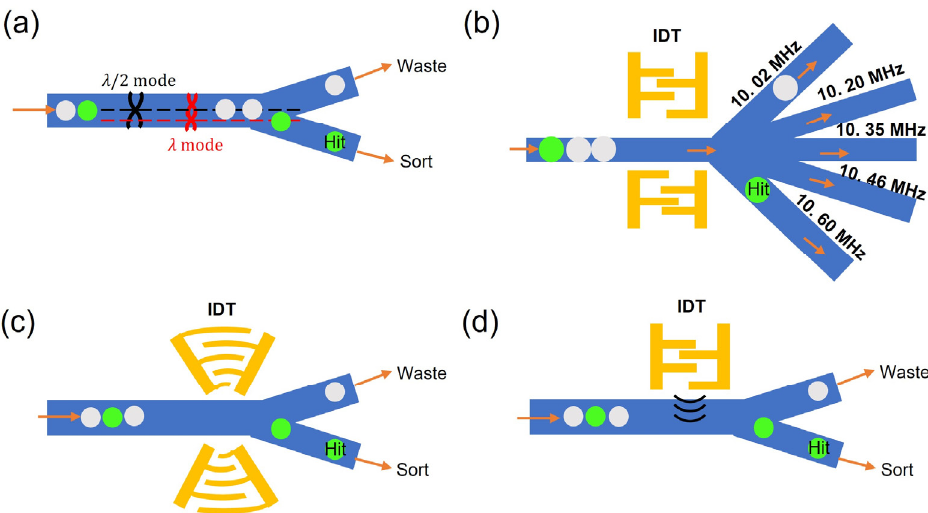
Figure 6. Variety of different versions of acoustic-based droplet sorters. ( a ) BAW droplet sorter that utilizes the switching of λ and λ /2 mode to achieve the droplet sorting towards different downstream channels. ( b ) A SSAW droplet sorter that can utilize two pairs of standard IDTs to sort droplets toward different downstream channels by using different actuation frequencies. ( c ) Developed single-phased, focused transducer method that utilized a revised IDT structure to achieve sorting with higher energy efficiency. ( d ) TSAW droplet sorter that pushes all droplets towards the bottom channel when switched on.